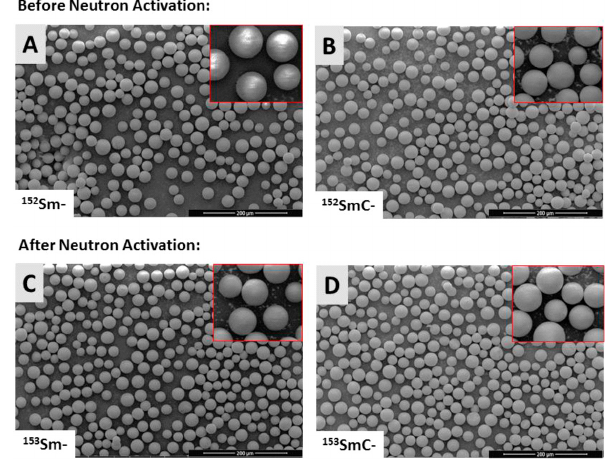
Figure 3. Scanning electron images of the Sm- and SmC-labeled microspheres both before ( A , B ) and after ( C , D ) 6 h neutron activation. The insets in the panels show the smooth surface morphology of the Sm- and SmC-labeled microspheres both before and after 6 h neutron activation, scale bar at the right bottom represent 200 µm.